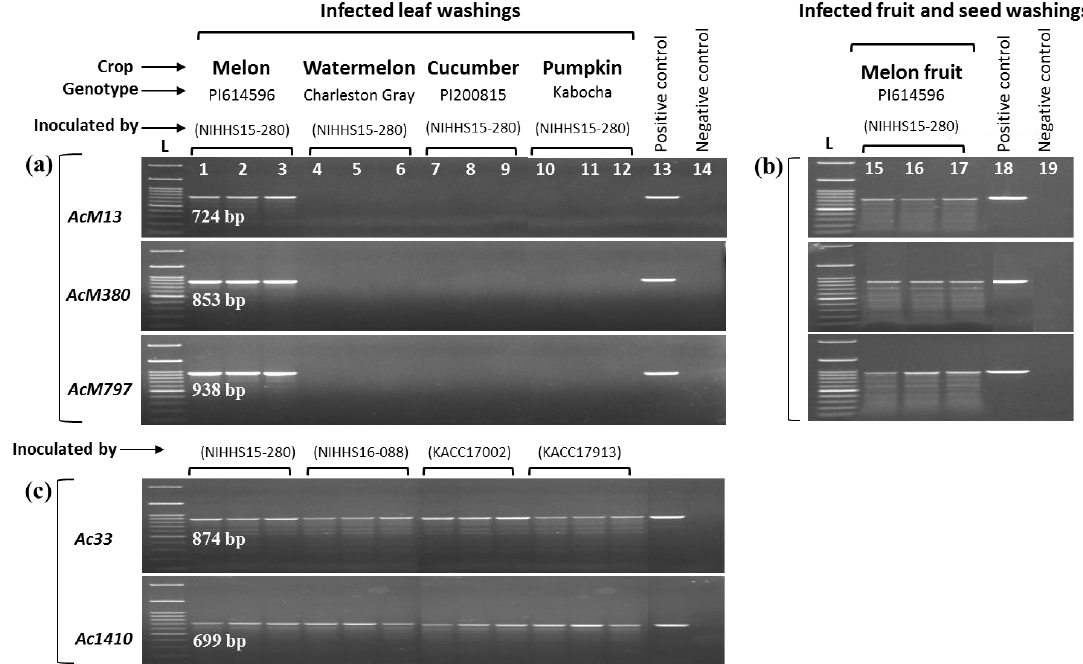
Figure 4. Bio-PCR detection of A. citrulli from the artificially infected leaf, fruit and seed washings using the primers designed based on whole-genome alignment. ( a ) Artificially infected (inoculated with NIHHS15-280) leaf and ( b ) fruit/seed washings were used as PCR templates for the “ Ac M” strain-specific primer sets AcM13, AcM380 and AcM797. A. citrulli -strain specific primer sets Ac33 and Ac1410 detected all A. citrulli strains from the leaf washings of melon, watermelon, cucumber, and pumpkin infected by the virulent strains NIHHS15-280, NIHHS16-088, KACC17002, and KACC17913, respectively ( c ). Three independent samples for each crop–strain combination were assessed. gDNA of A. citrulli strain NIHHS15-280 (lanes 13, 18) and double distilled water (lanes 14,